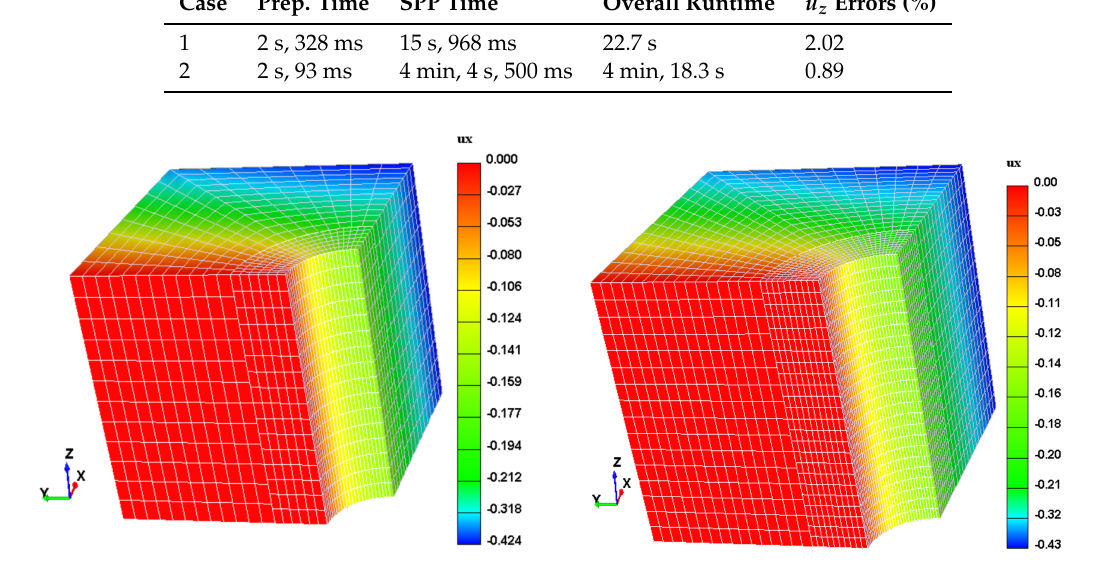
Figure 21. MFEM solutions for Bradley 3-D.